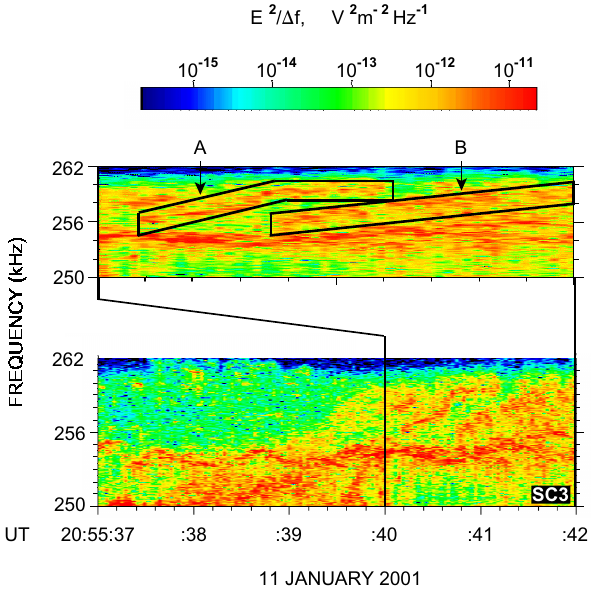
Fig. 13. (a) Two-second spectrum of AKR emission from SC3 on 11 January 2001 between 20:55:40 and 20:55:42UT. Note the two narrowband, drifting AKR sources labeled A and B. Cross- correlation analysis of both events were performed with similar measured delays. The cross-correlations shown in Fig. 14 were cal- culated using a 300-msec time window near the end of the source B track. (b) Five-second spectrum showing the nearby AKR activity at the time of events A and B. SC3 means that the signals arrived at SC3 before SC1.